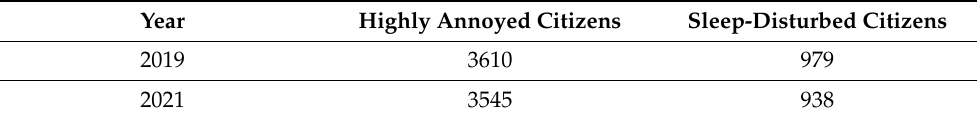
Table 2. Total citizens of Piombino highly annoyed and sleep-disturbed in 2019 and 2021.